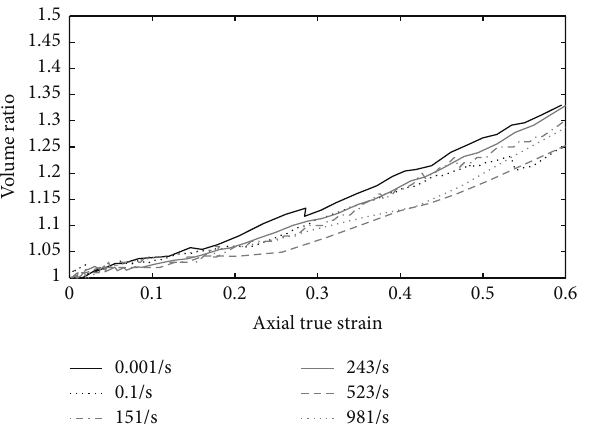
Figure 9: Stress-strain behavior at different strain rates.